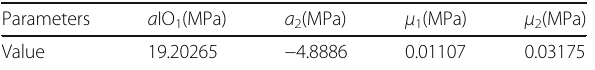
Table 3 Parameters of the Ogden model Parameters